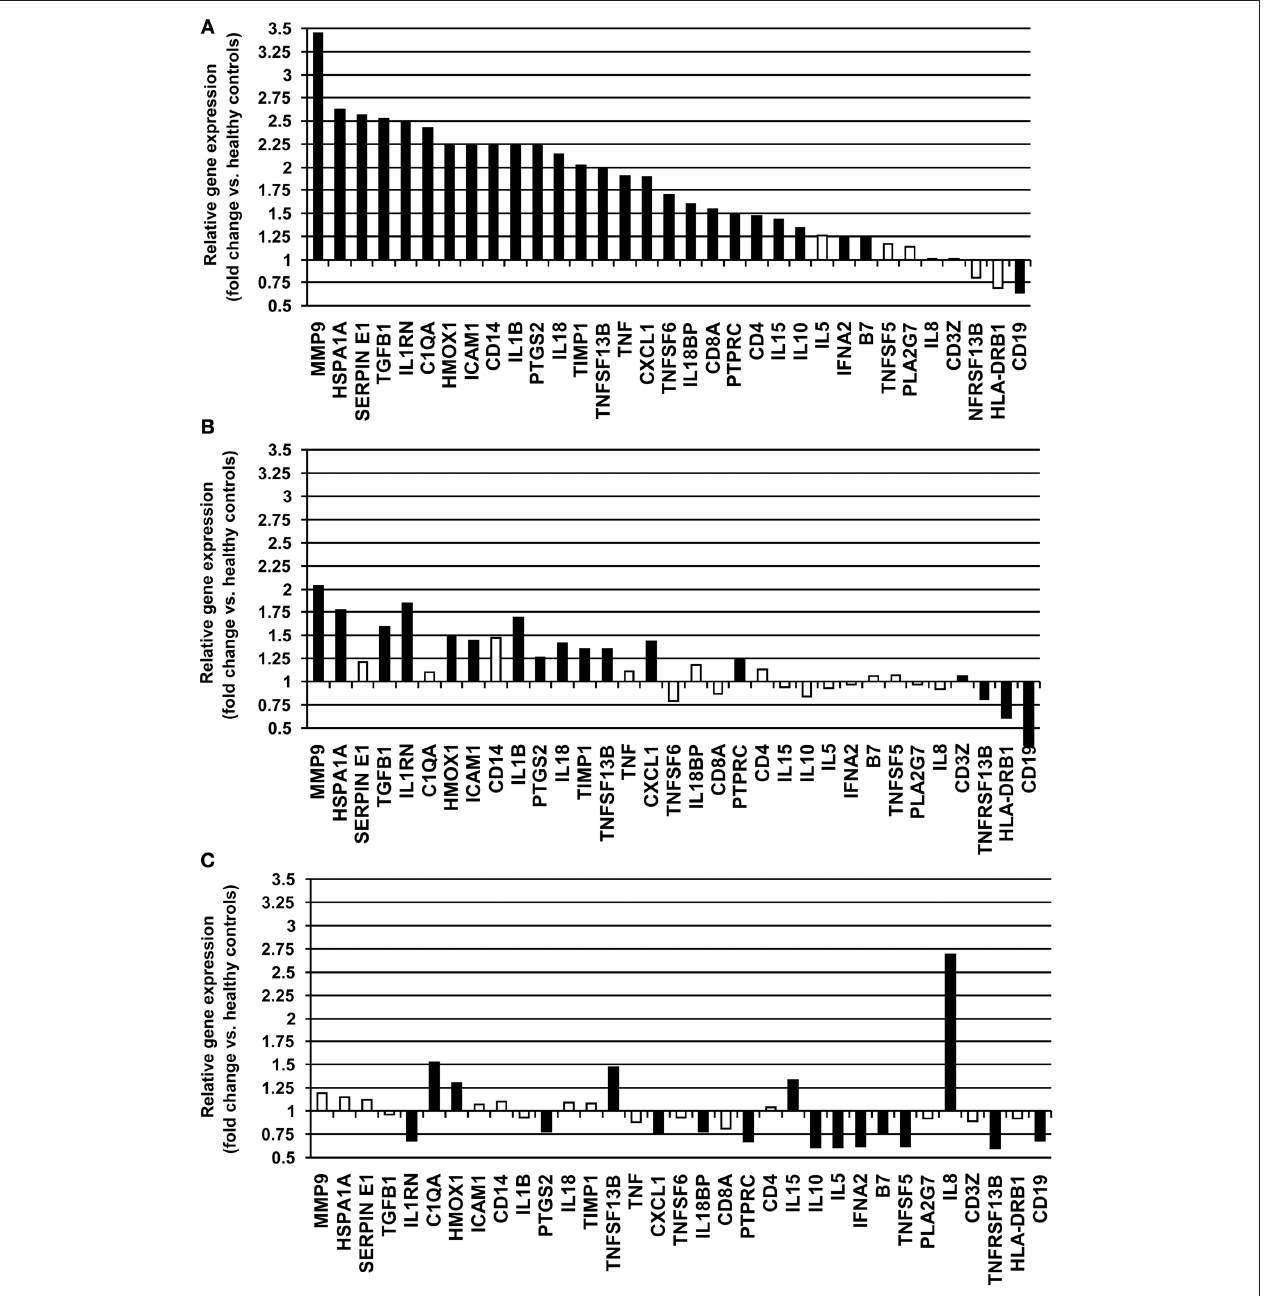
FIGURE 1 | Relative fold-changes in whole blood gene expression in RA patients compared to healthy controls. (A) Unstable RA patients on DMARD therapy ( n = 18). (B) Stable RA patients on DMARD therapy ( n = 26). (C) Stable RA patients on combined DMARD and anti-TNF- α therapy